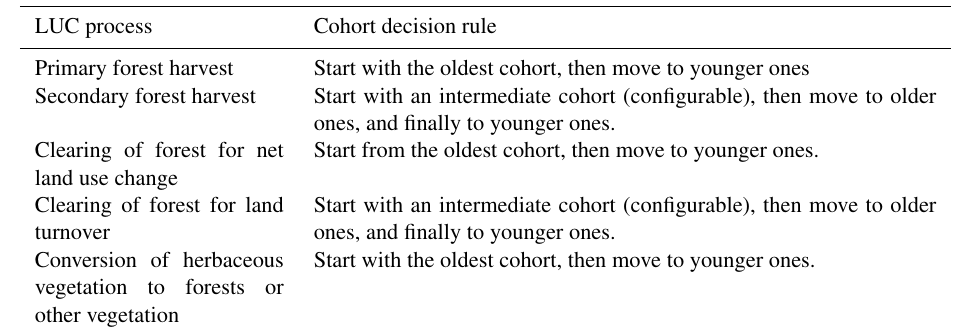
Table 2. A set of implemented rules regarding cohort selection for different land use change processes. LUC process Cohort decision rule Primary forest harvest Start with the oldest cohort, then move to younger ones Secondary forest harvest Start with an intermediate cohort (configurable), then move to older ones, and finally to younger ones. Clearing of forest for net Start from the oldest cohort, then move to younger ones. land use change Clearing of forest for land Start with an intermediate cohort (configurable), then move to older turnover ones, and finally to younger ones. Start with the oldest cohort, then move to younger vegetation to forests or other vegetation